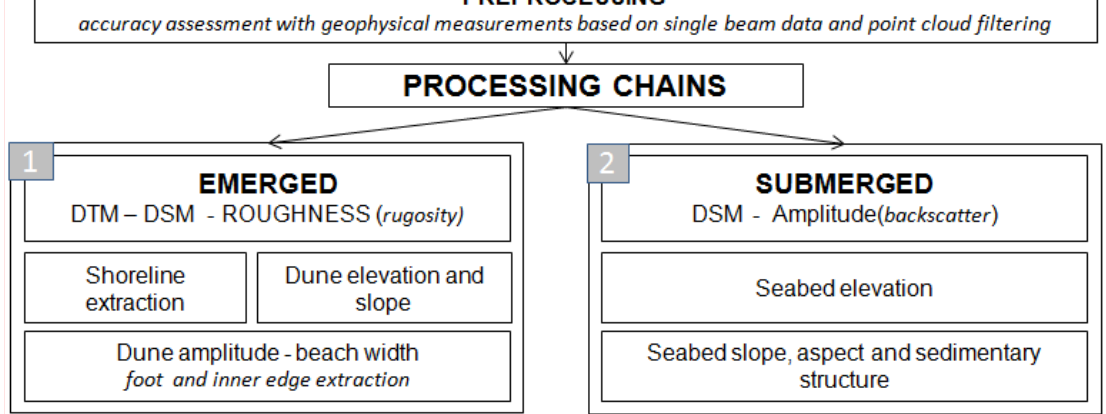
Figure 3. Scheme of the processing chain of the FHyL approach. The module 2 represents the FHyL module to be used for the characterisation of submerged coastal areas (see [51] for more details).